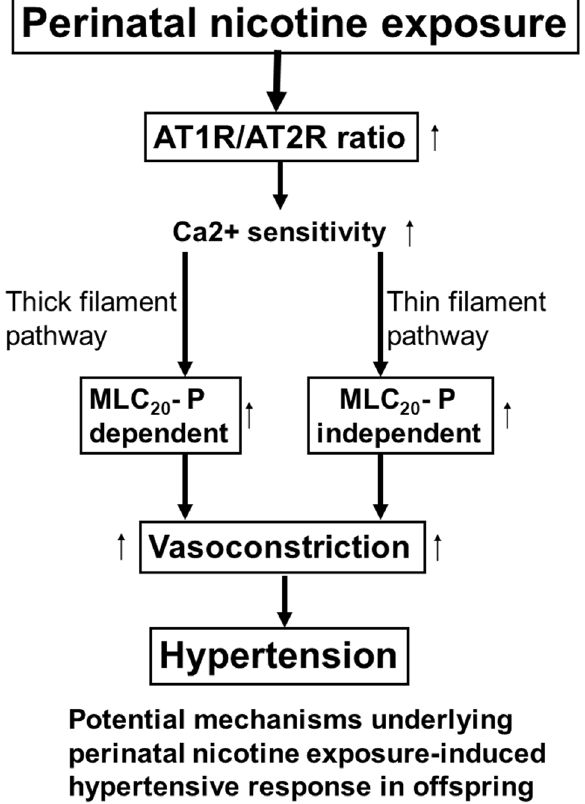
Figure 7. Diagram of potential mechanisms underlying fetal nicotine exposure-induced hypertensive response in adult offspring. Perinatal nicotine exposure enhances AT 1 R and attenuate AT 2 R gene expression through DNA methylation mechanism. Nicotine- mediated enhanced AT 1 R/AT 2 R ratio predominately heightens Ca 2 + sensitivity of myofilaments, leading to exaggerated vasoconstriction through both MCL 20 phosphorylation-dependent (thick filament) and – independent (thin filament) signaling pathways and development of hypertensive phenotype in adult